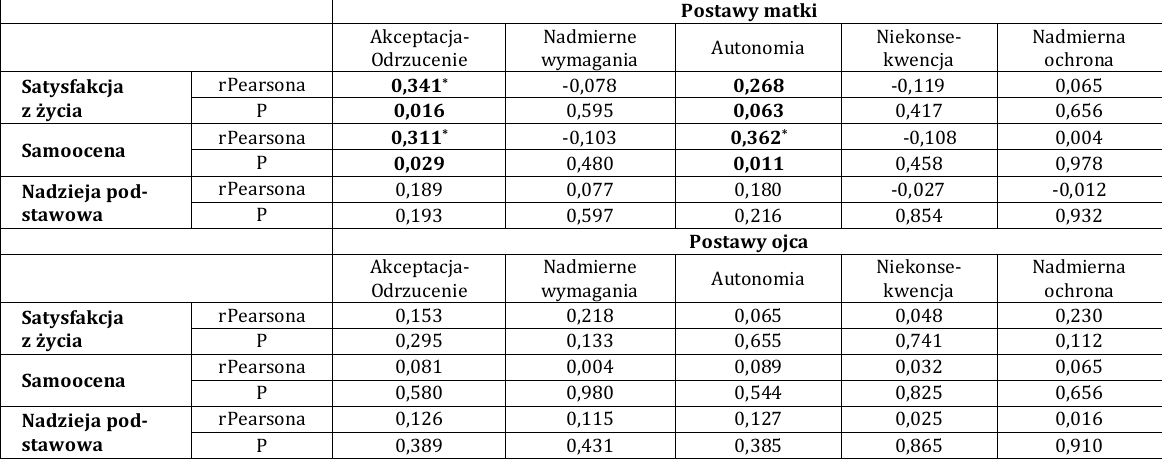
Tabela 1. Weryfikacja istotności, siły i kierunku związków pomiędzy postawami rodziców a poziomem satysfakcji z życia, samooceny i nadziei podstawowej dorosłych osób z zespołem DDA